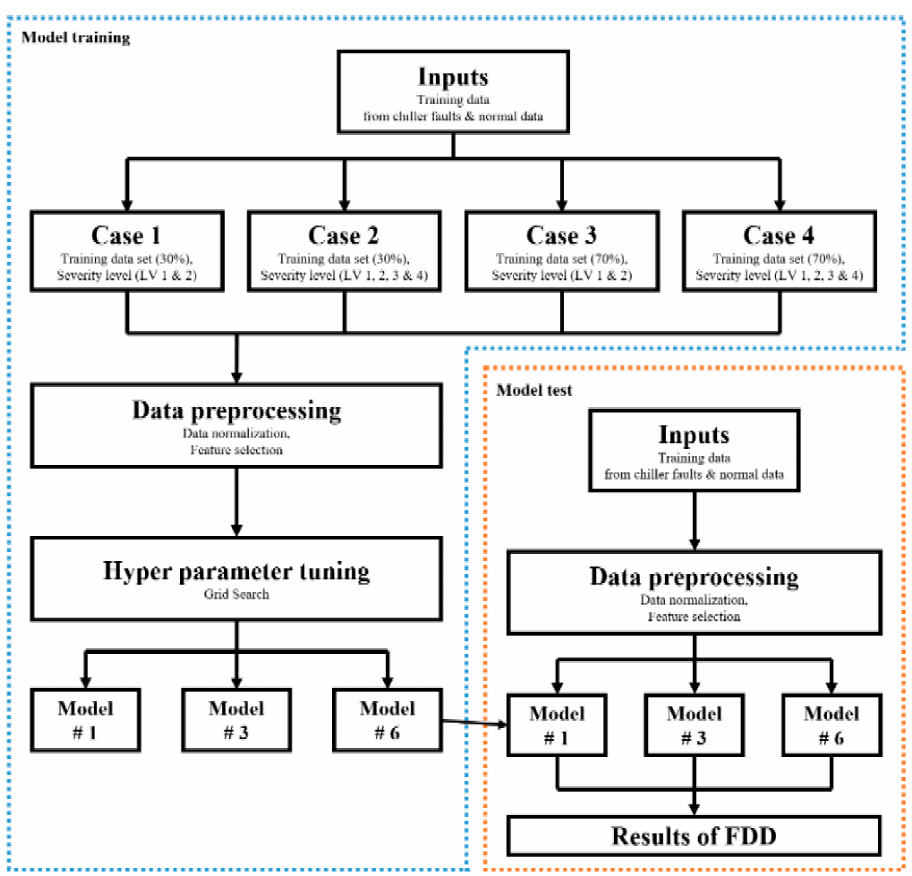
Figure 1. Schematic of proposed FDD